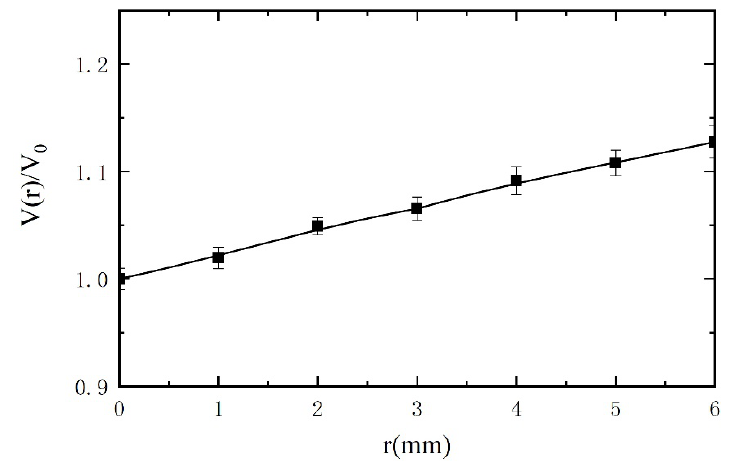
Figure 12. The output voltage relative to r = 0 value when metal debris passes through different